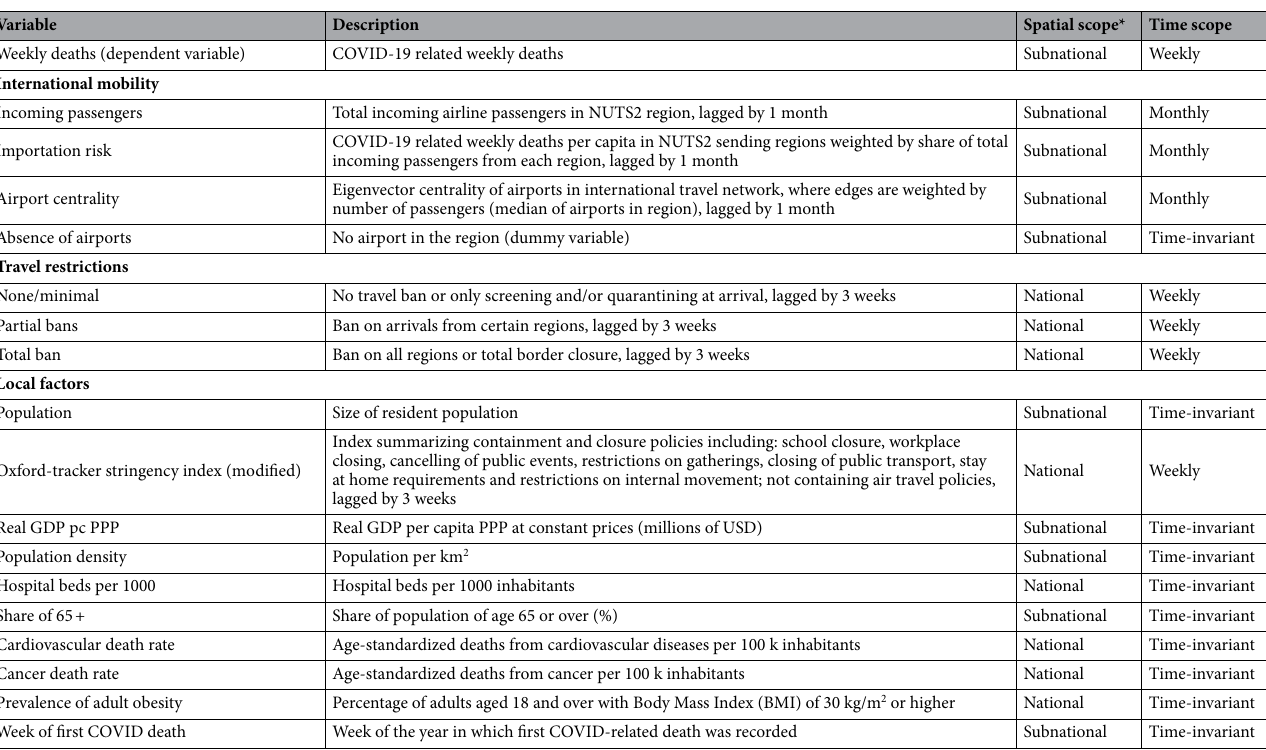
Table 1. Description of the variables used in the models of precocity and severity of COVID-19 (April– October 2020). Source : Sub-National COVID-19 Incidence and Determinants Dataset. *The subnational level corresponds to the NUTS2 level in Europe and comparable administrative regions in non-European countries (e.g., in the US corresponding to Federal